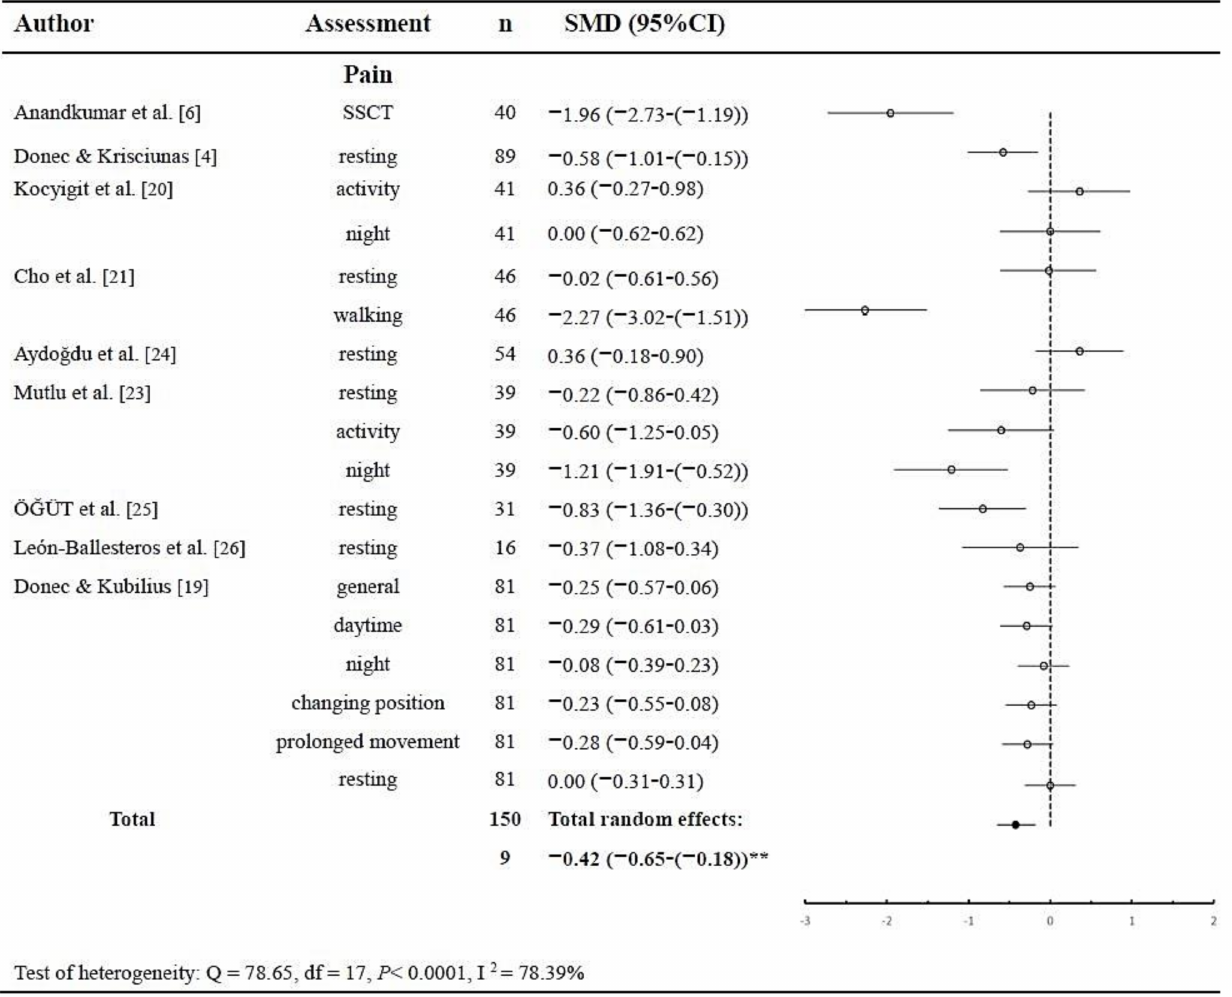
Figure 2. Pooled estimate of effects on pain with kinesio taping ** p < 0.05 ( n = number of subjects; SMD = standard mean difference; CI = confidence interval; SSCT = standardized stair climbing task; df = degree of